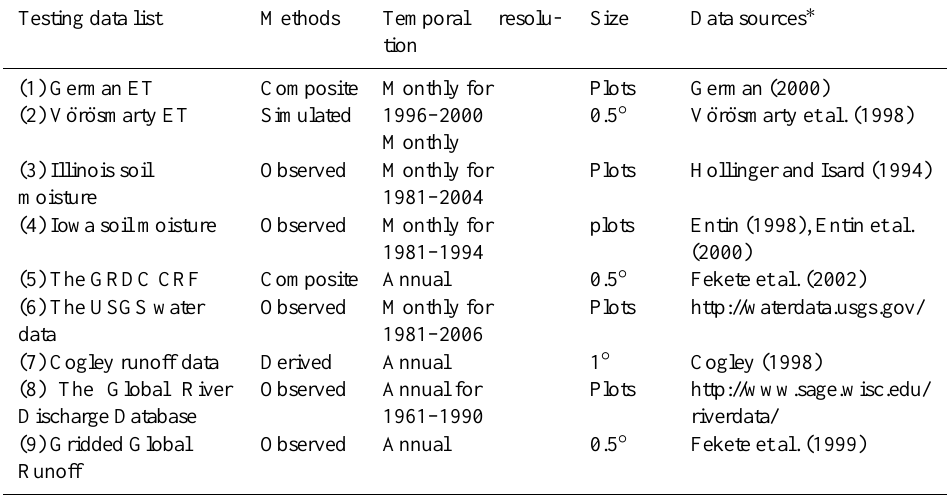
Table 3. List of observed and simulated data to test LH’s performance. Testing data list